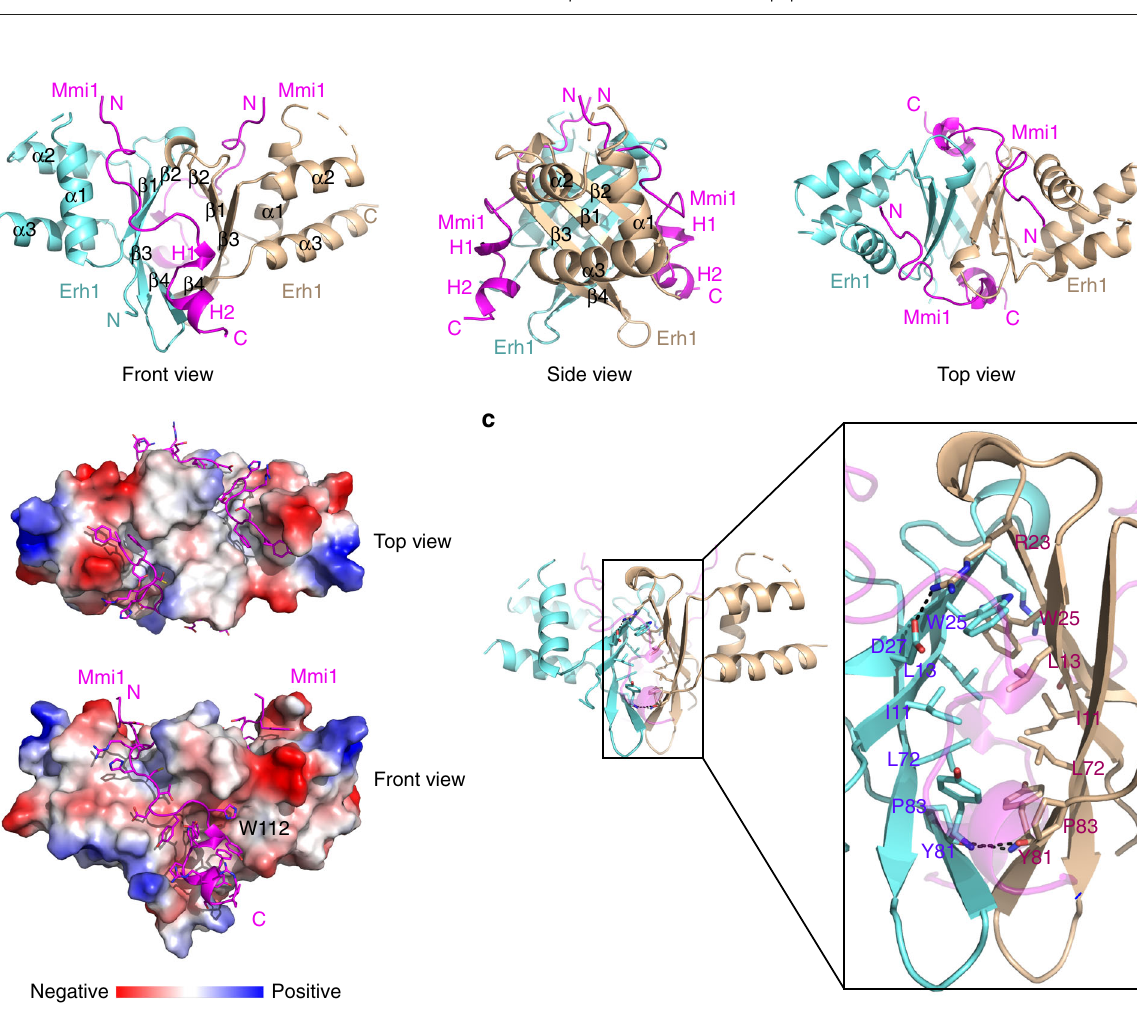
Fig. 2 Structure of Erh1 in complex with Mmi1 95 – 122 peptide. a Ribbon representations of Erh1 bound to Mmi1 95 – 122 peptide. One monomer of the Erh1 homodimer is colored in aquamarine, while the other is colored in wheat. The two bound Mmi1 95 – 122 peptides are colored in magenta. b The two Mmi1 95 – 122 peptides are represented as sticks on the molecular face of the Erh1 homodimer. Red and blue colors denote negative and positive surface charge, respectively. c Ribbon representation of the interface of the Erh1 dimer. The residues at the dimer interface are shown as sticks. The hydrogen bonds formed at the dimer interface are depicted as black dashed lines